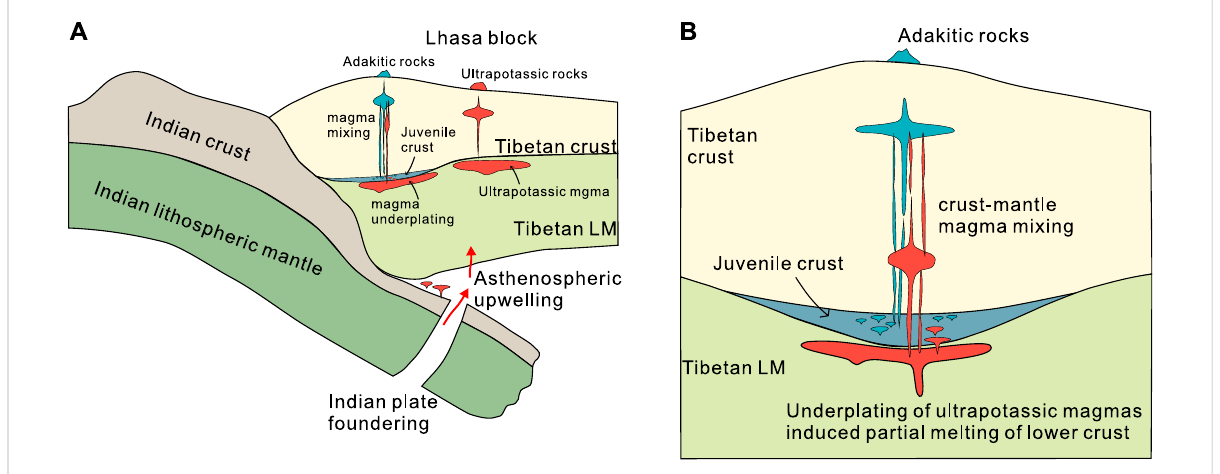
FIGURE 7 (A) Schematic illustration for the formation of adakitic trachyandesites. (B) Schematic model for the interaction of ultrapotassic magmas with lower crust. LM, lithospheric mantle. The subducted Indian continental plate experienced foundering, which triggered the asthenosphere upwelling and partial melting ofmetasomatizedlithosphericmantle to generate ultrapotassicmagmas.The underplating ofultrapotassic magmas beneaththe lowercrustoftheLhasablockinducedpartialmeltingofthejuvenilelowercrust.Mixingbetweenthejuvenilelowercrust – derivedmeltsandthe ultrapotassic magmas formed the Sailipu high-K calc-alkaline and adakitic